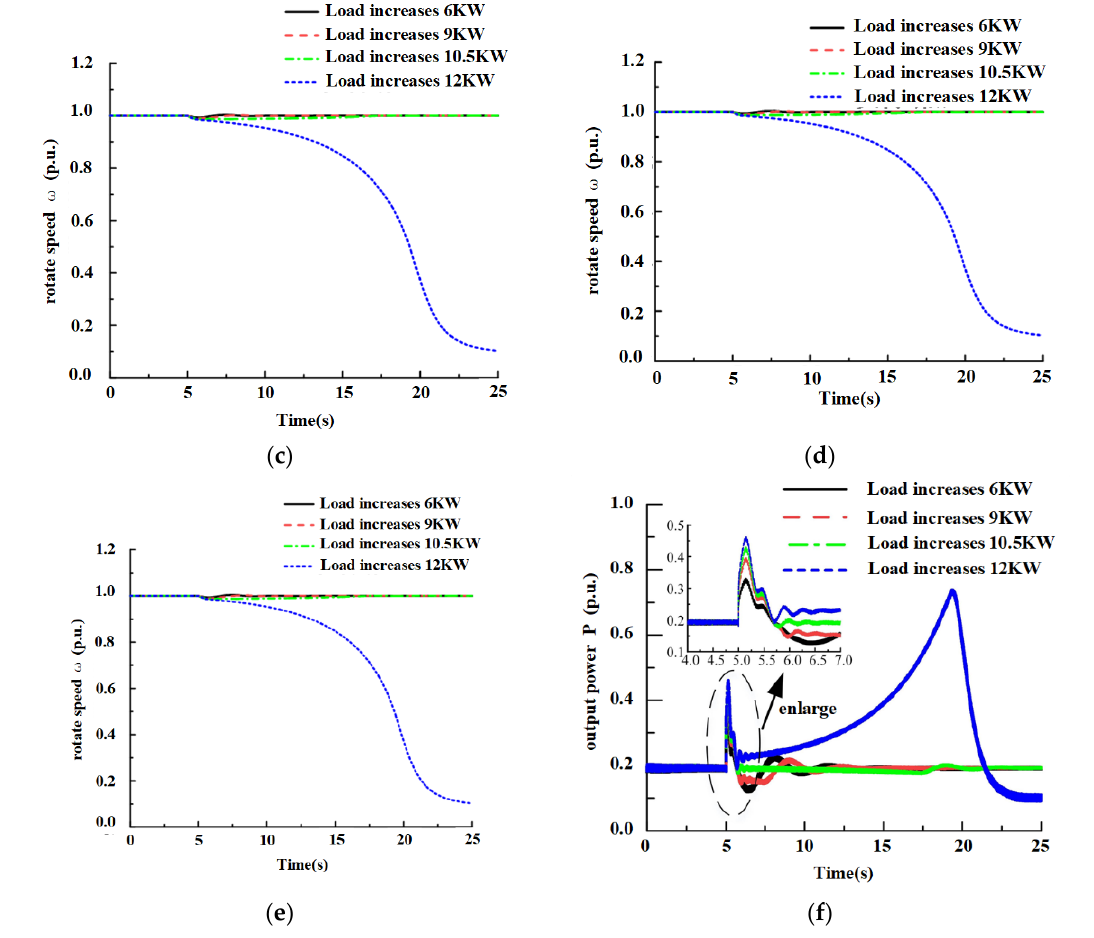
Figure 13. Simulation curve of the system response under a sudden increase of load. ( a ) The demand load increase curve. ( b ) System frequency response curve. ( c ) Conventional generator speed response curve. ( d ) The rotor-speed response curve. ( e ) Wind-driven generator speed response curve. ( f ) Active power output of rotor response curve.